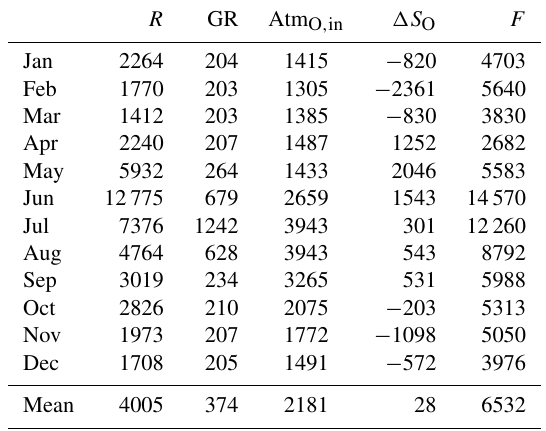
Table 10. 1993–2018 adjusted mean annual cycle of the Arctic Ocean’s hydrological cycle; units are km 3 yr − 1